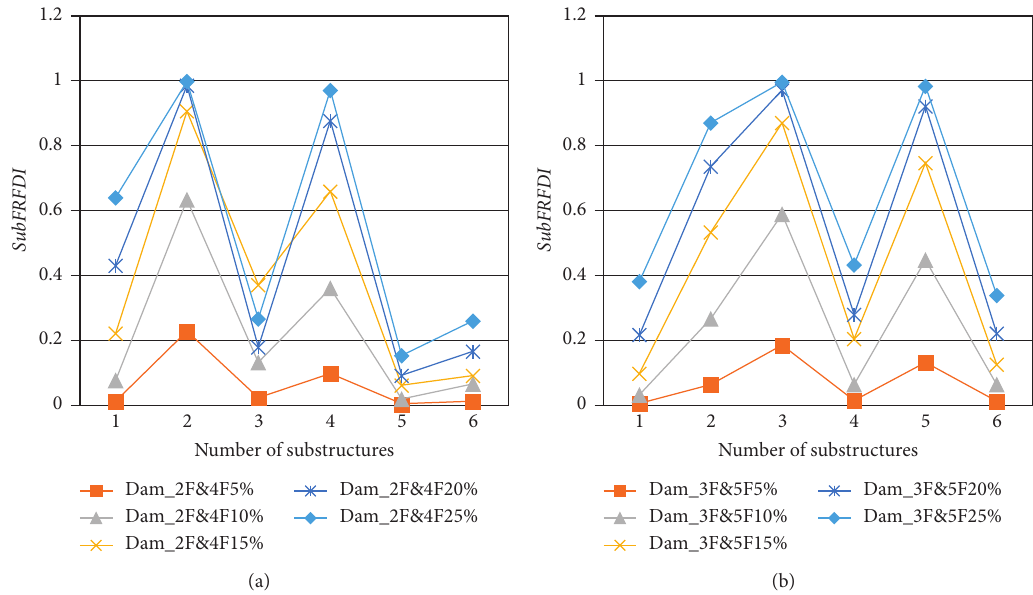
Figure 11: The comparison of the SubFRFDI for 5%, 10%, 15%, 20%, and 25% stiffness reduction in (a) the 2 nd and the 4 th floors and (b) the 3 rd and the 5 th floors.